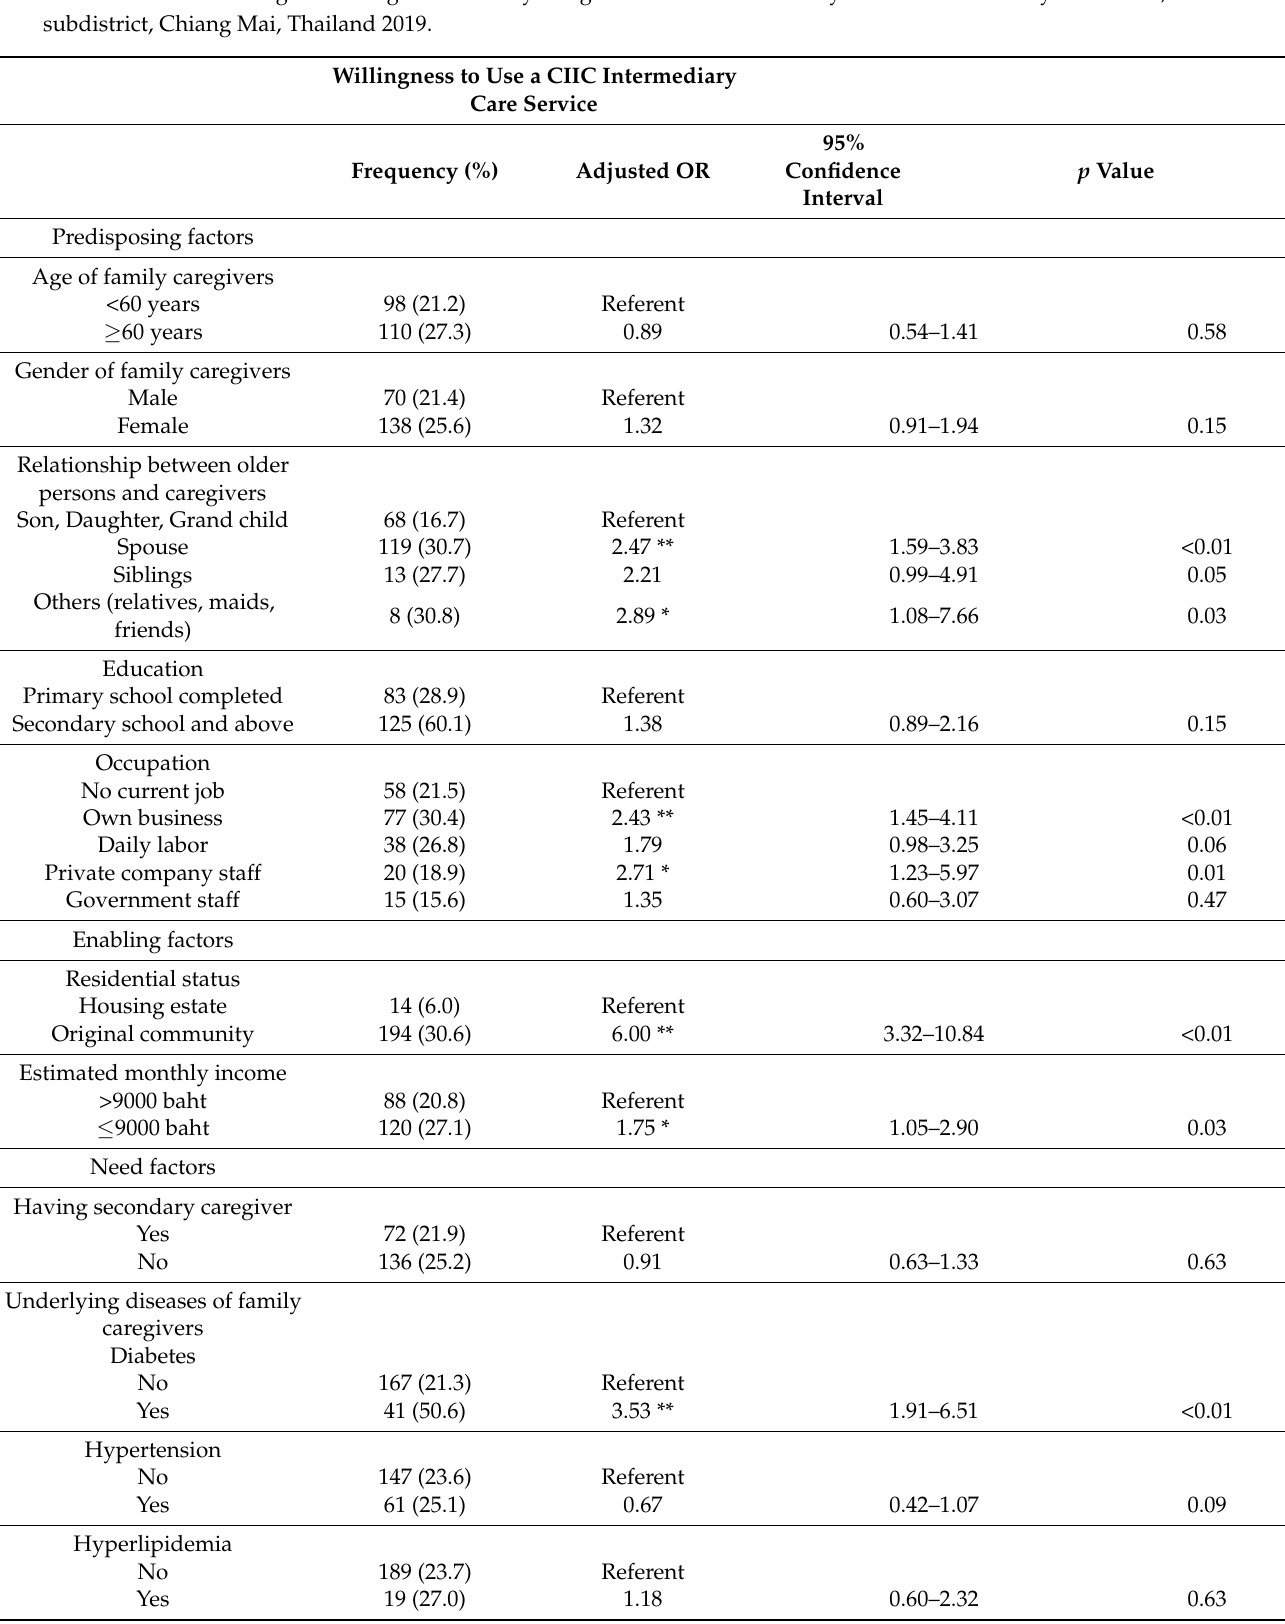
Table 3. Factors affecting the willingness of family caregivers to send their elderly to CIIC Intermediary care center, Maehia subdistrict, Chiang Mai, Thailand